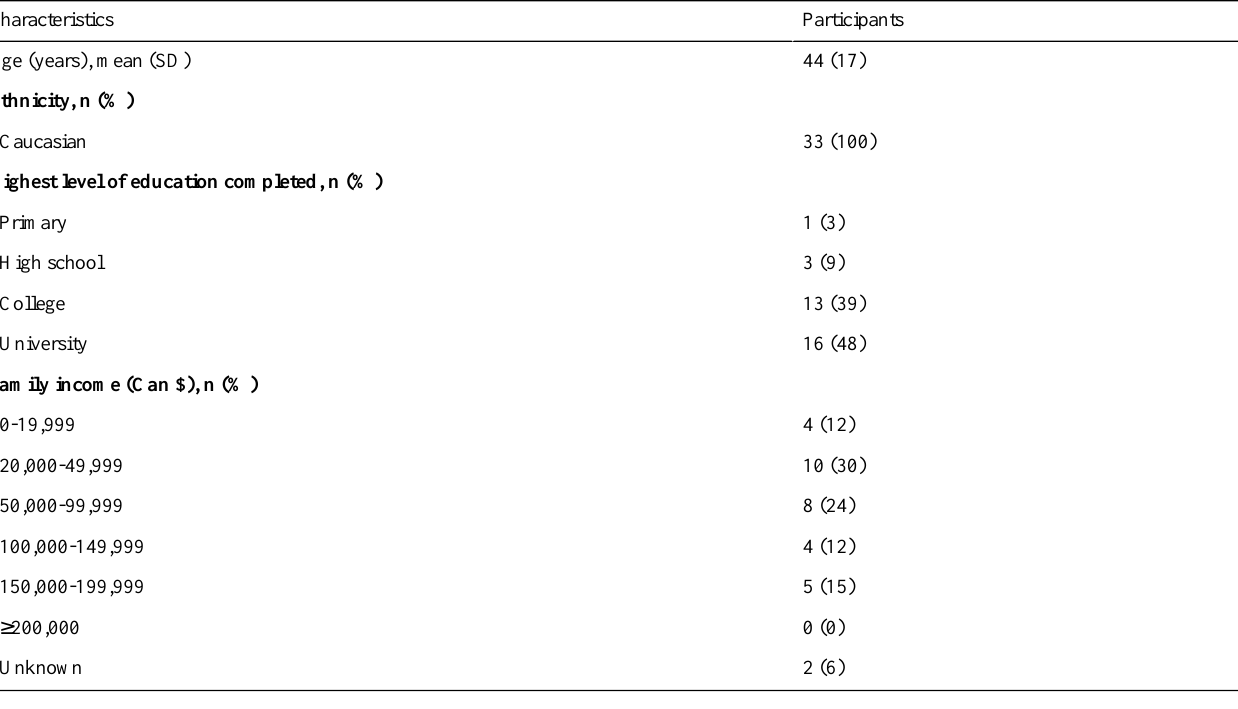
Table 1. Sociodemographic characteristics of the 33 participants.